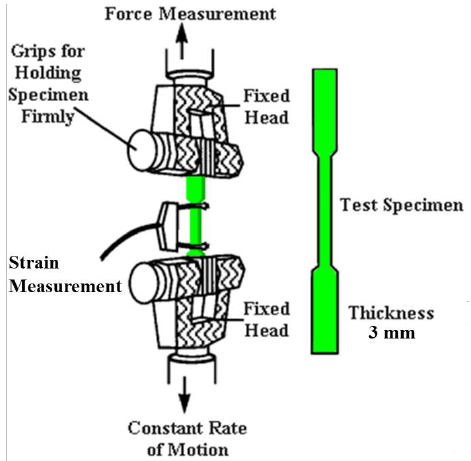
Figure 2. Visualization of tensile testing set up of specimens made in this study.